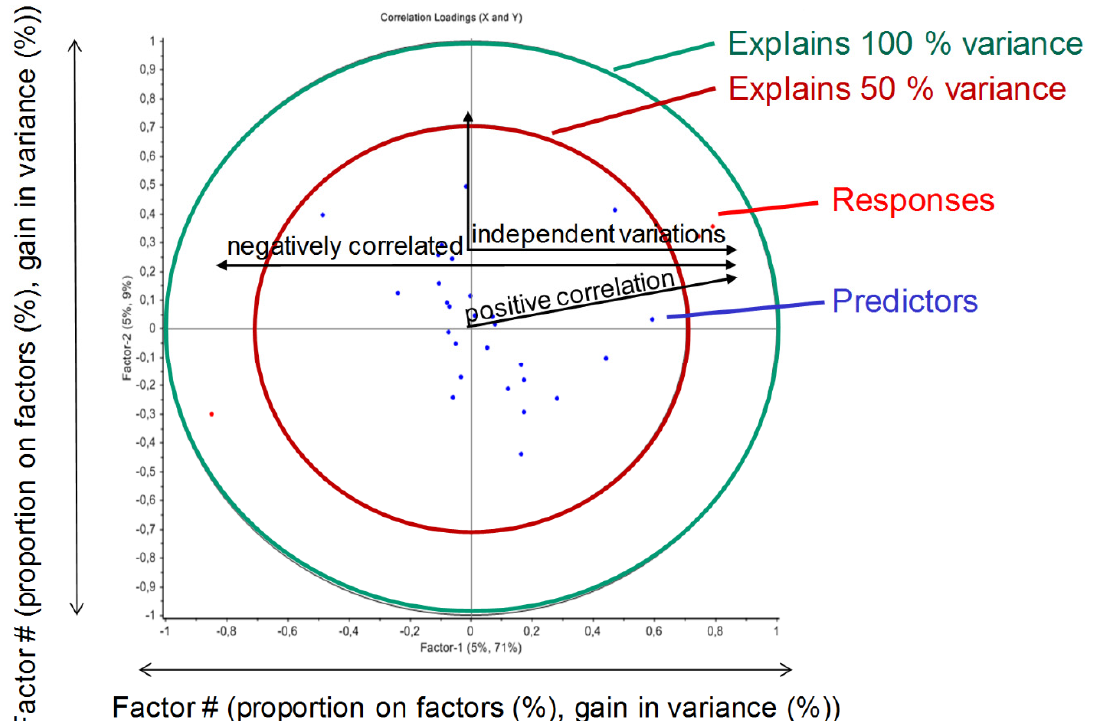
Figure 7. Schematic presentation of a loadings plot resulting from a partial least squares (PLS) regression.